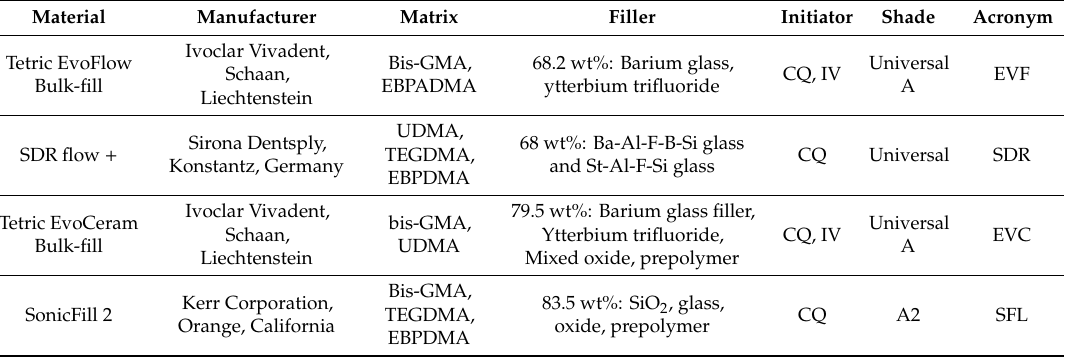
Table 1. Bulk-fill resin based composite (RBC) composition. The initiator system is based on camphorquinone (CQ) and ivocerin